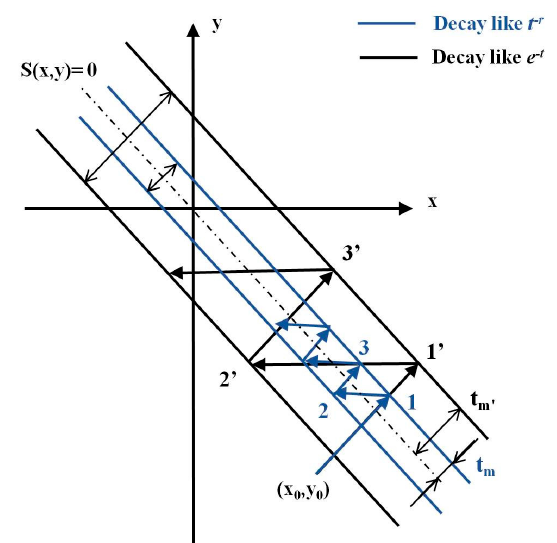
Figure 1. Comparison of energy transfer during sliding motion of FOSMC (blue line) and IOSMC (black line) [4].